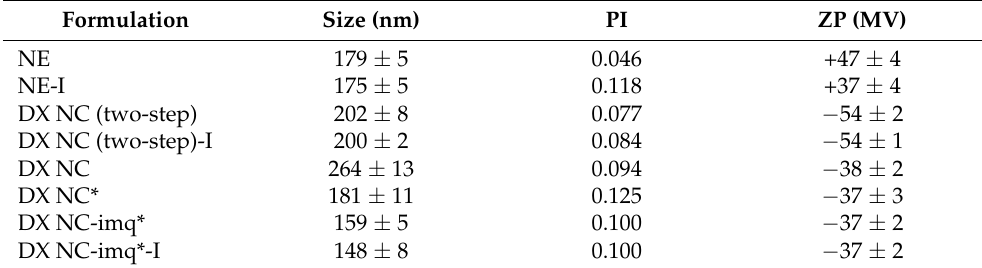
Table 1. Physicochemical characterization (mean particle size, polydispersity index (PI), and zeta potential (ZP)) of the nanosystems designed using either a one-step or two-step methodology. NE: nanoemulsion. DX NC: dextran nanocapsules. I: Isolated nanosystems. * Formulation